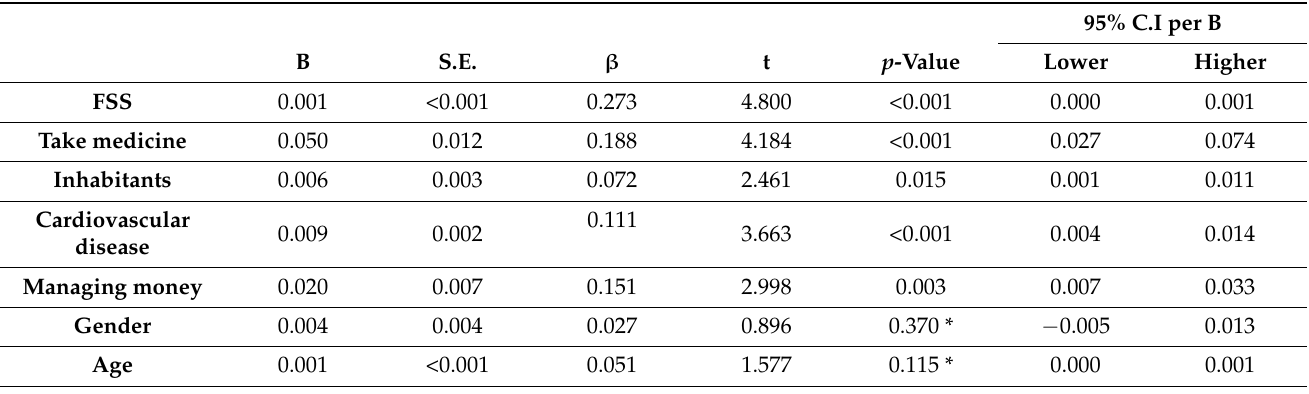
Table 4. Multivariate Linear Regression